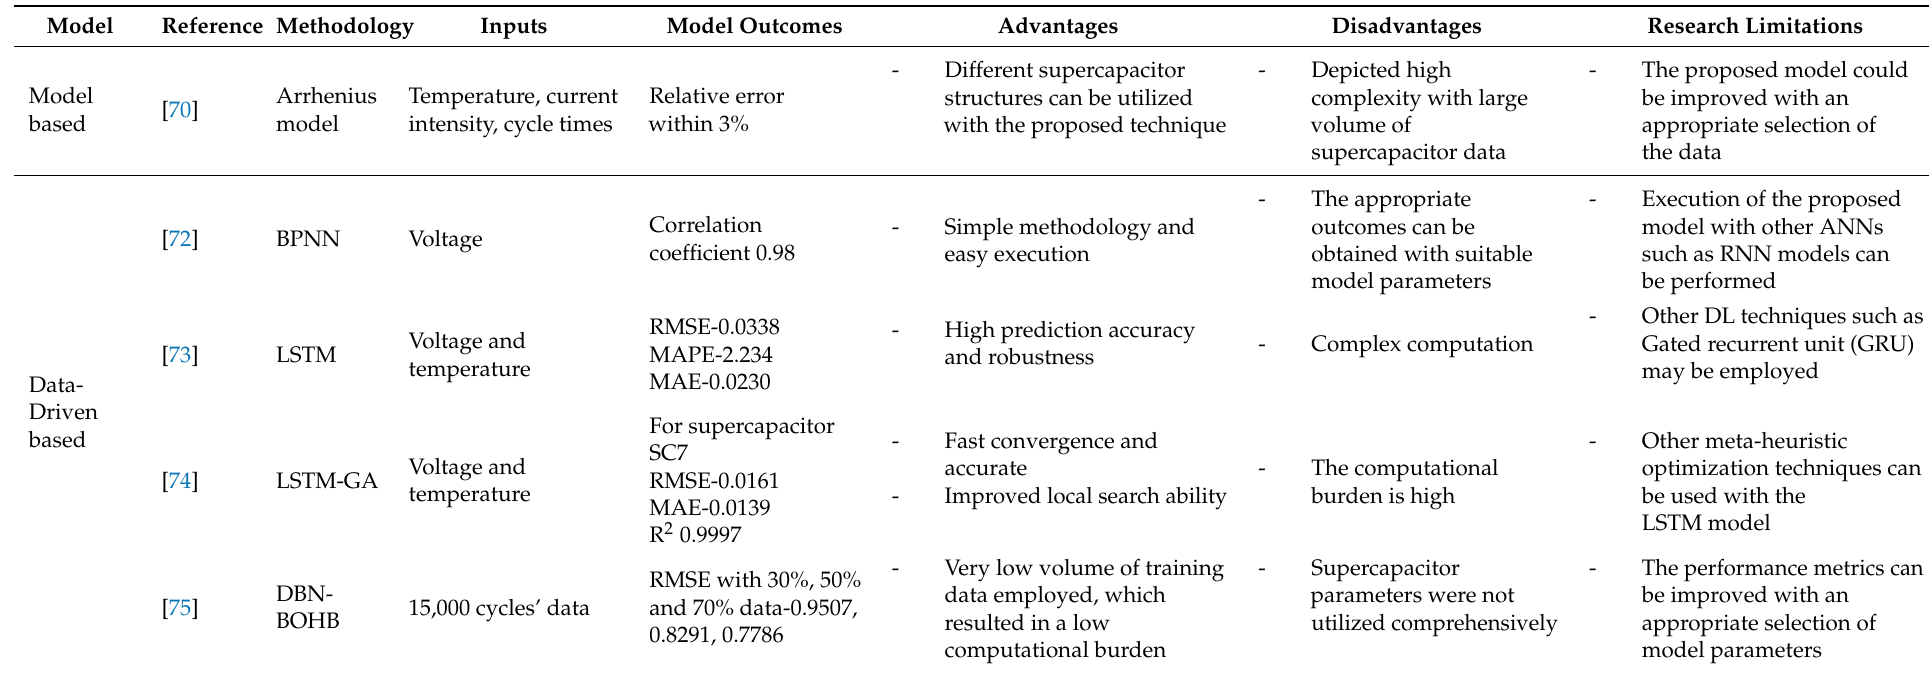
Table 3. Comparative analysis of model-based and data-driven-based RUL estimation technique for